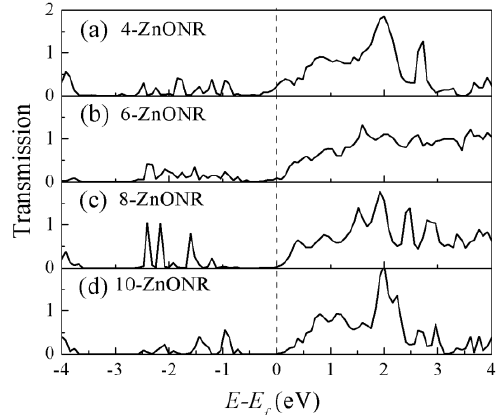
Figure 2. Transmission spectrum of the n -ZnONR (( a ): n = 4, ( b ): n = 6, ( c ): n = 8, ( d ): n = 10) device at equilibrium, and the zero of the energy is set to Fermi level.